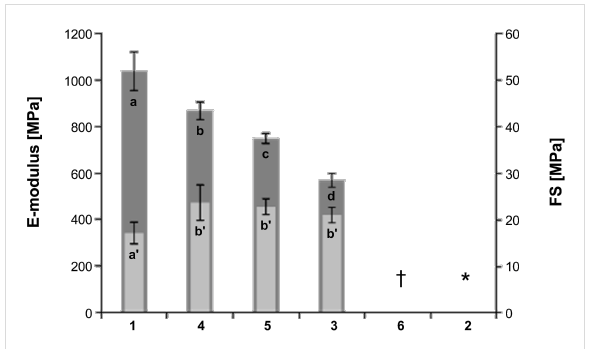
Figure 7: Flexural strength (FS) and E-modulus of cured crosslinkers 1 – 6 ; letters refer to statistical groups (* gel-like polymer, pretest failure; † brittle polymer, pretest